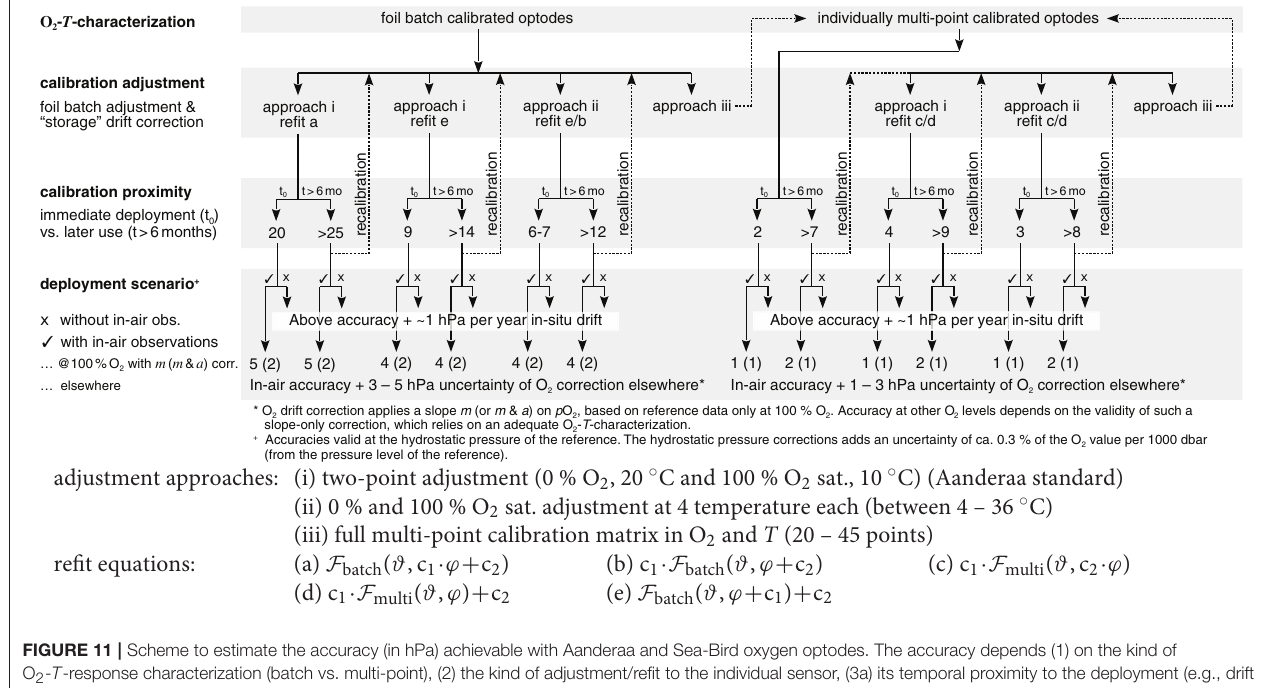
FIGURE 11 | Scheme to estimate the accuracy (in hPa) achievable with Aanderaa and Sea-Bird oxygen optodes. The accuracy depends (1) on the kind of O 2 - T -response characterization (batch vs. multi-point), (2) the kind of adjustment/refit to the individual sensor, (3a) its temporal proximity to the deployment (e.g., drift during storage or shipment), as well as (3b) whether in-air observations are performed during the deployment. With in-air observations, the accuracy at 100 % O 2 saturation is given once using (Equation 21) (to derive a correction factor m ) and once using (Equation 23) (to derive a correction factor m by including a temperature-compensation a of the O 2 - T -response at 100 %; in brackets). At O 2 levels other than 100 % O 2 saturation, some additional uncertainty remains with respect to the in-situ drift behavior and the O 2 - T -response. The hydrostatic pressure correction adds an uncertainty of ca. 0.3 % of the O 2 value per 1,000 dbar (from the pressure level of the reference/calibration). The adjustment approaches i–iii and refit equations a–e are given at the bottom of the scheme.